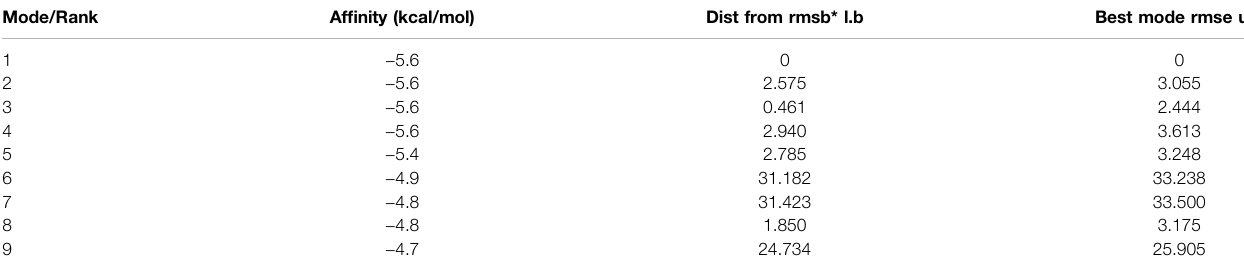
TABLE 1 | MOE scores of hP2X3 protein and gallic acid (kcal/mol). Mode/Rank Af fi nity (kcal/mol) Dist from rmsb* l.b